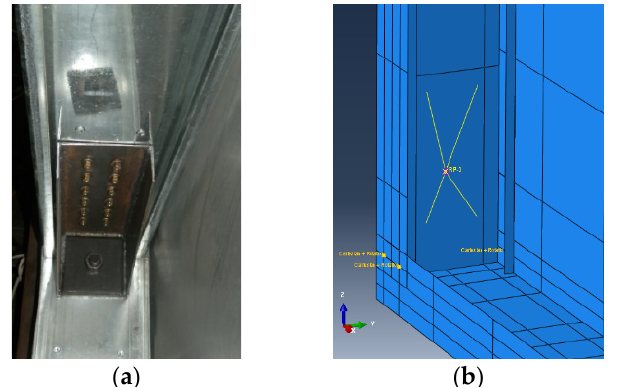
Figure 17. The hold-down device: ( a ) real component, ( b ) simplified finite element model.